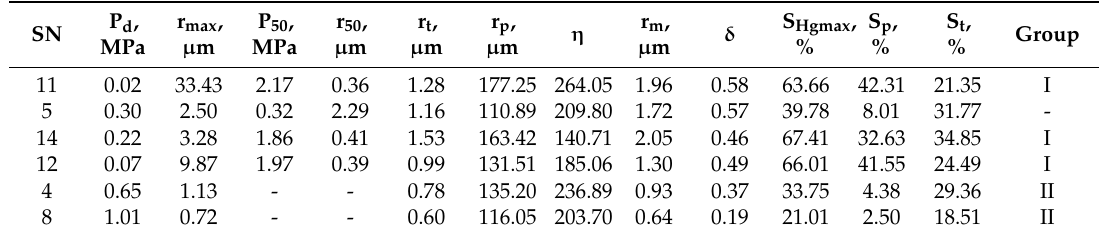
r t — average throat radius; r p — average pore radius; η — pore throat radius ratio; r m — mainstream throat radius; δ — sorting coefficient; S t — throat maximum mercury intrusion saturation; S p — pore maximum mercury intrusion saturation; S Hgmax — total maximum mercury intrusion saturation.